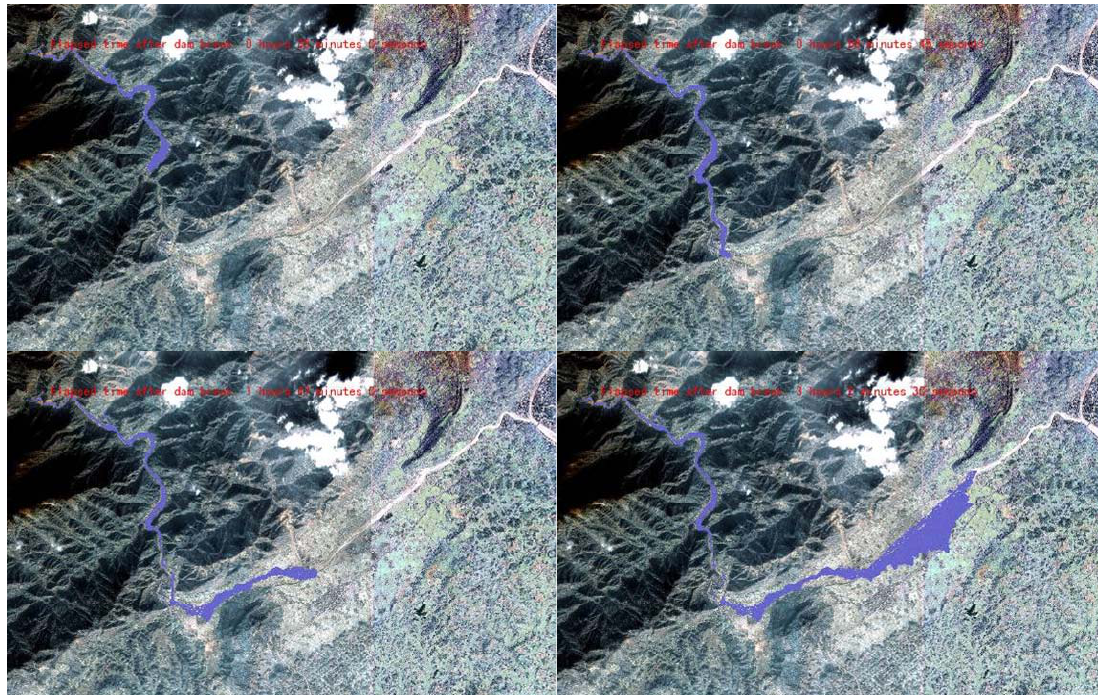
Fig. 8. Flood routing simulation results in 3-D visualization (5.19 half